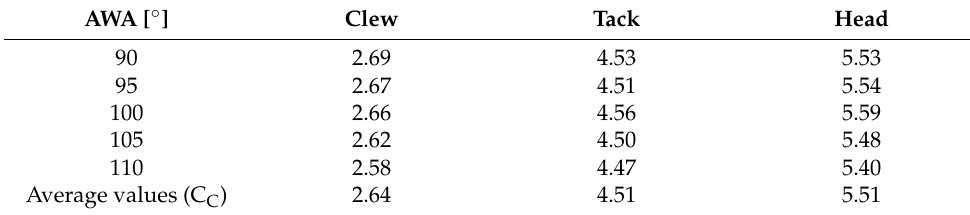
Table 5. Second order coefficients: single and average